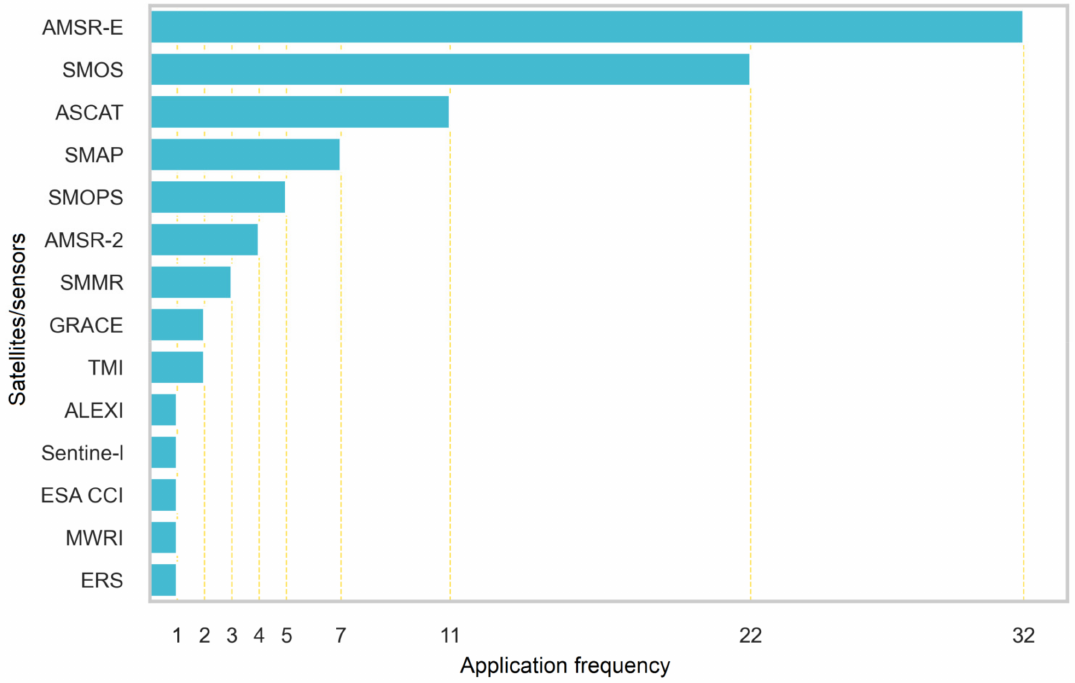
Figure 5. The application frequency (count) of satellite/sensor data for SM assimilation studies in the reviewed